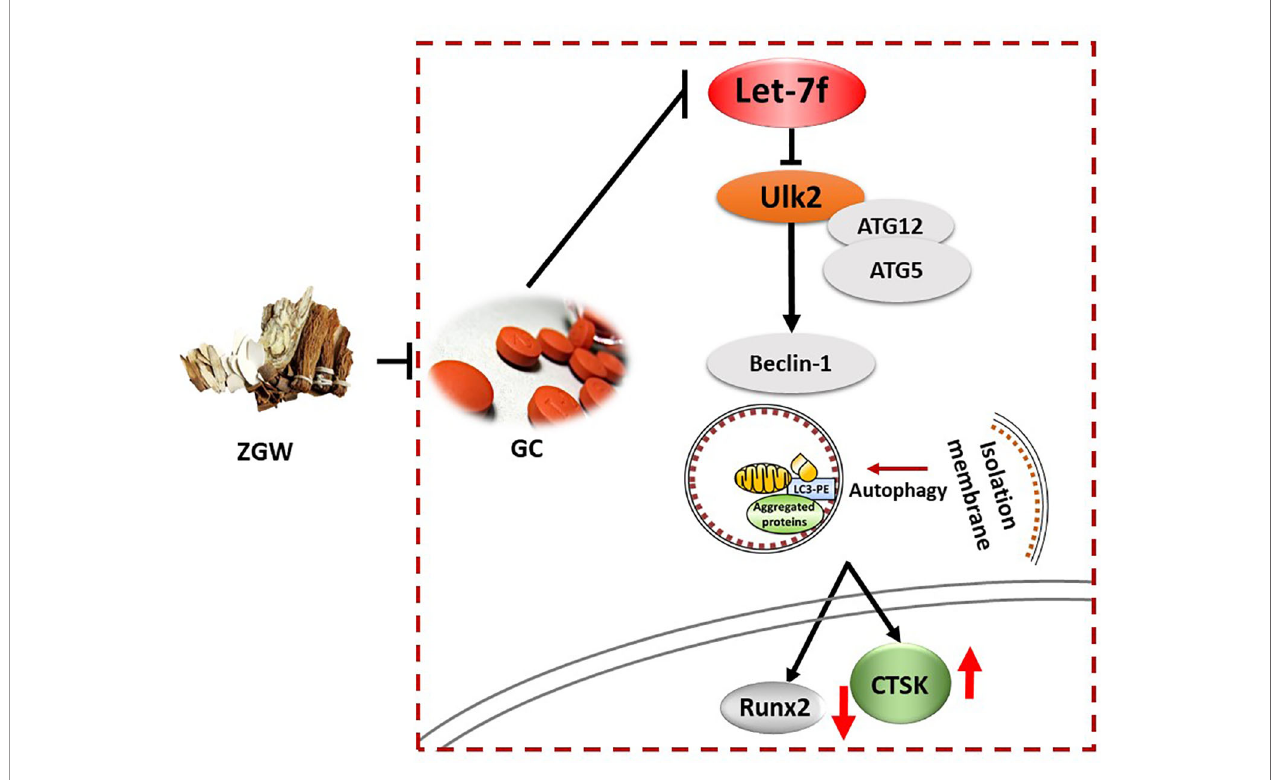
FIGURE 10 | Mechanism graphic of the